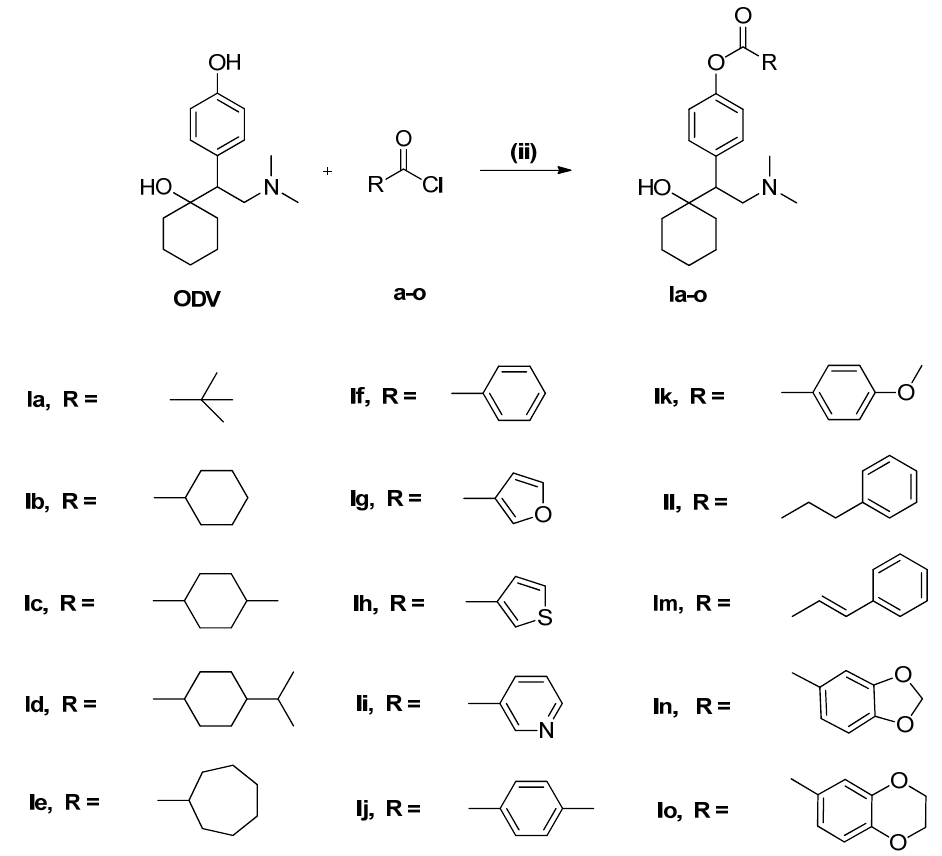
Table 1. Clog P of the esters and PK parameters of ODV after oral administration of 1a – o and ODV to rats at a dose of 0.02 mmol/kg (data are means ± SD, n = 4).